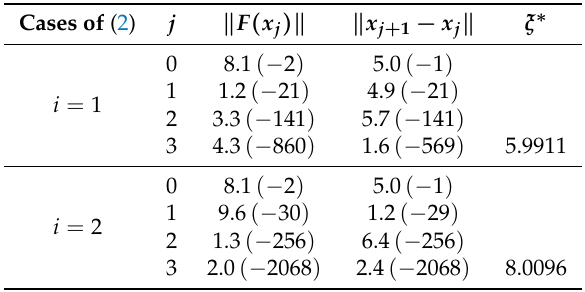
Table 6. Computational results of 2D Bratu problem in Example 6.